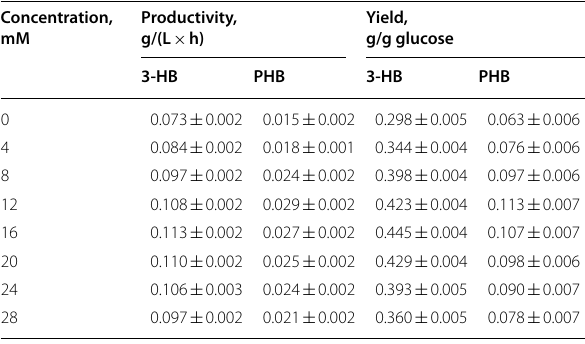
Table 5 The productivity and yield of 3-HB and PHB at